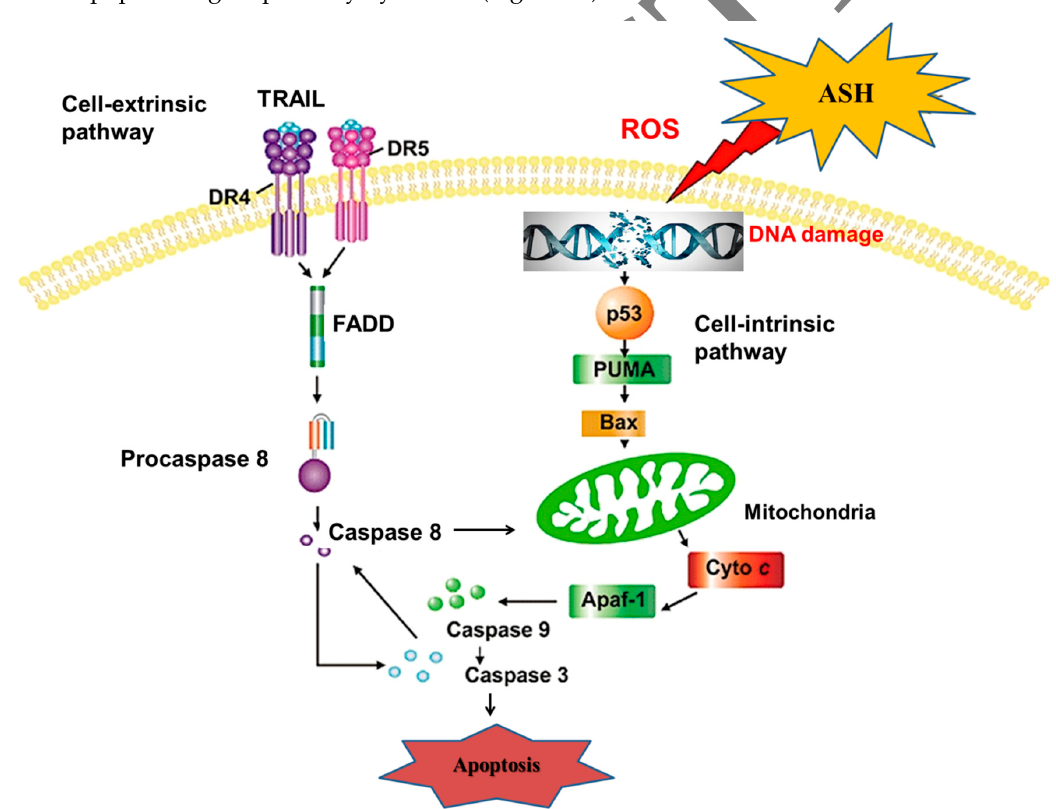
Figure 10. Diagram of molecular mechanisms underlying the synergic effects between ASH and TRAIL in promoting apoptotic cell death in HCC.